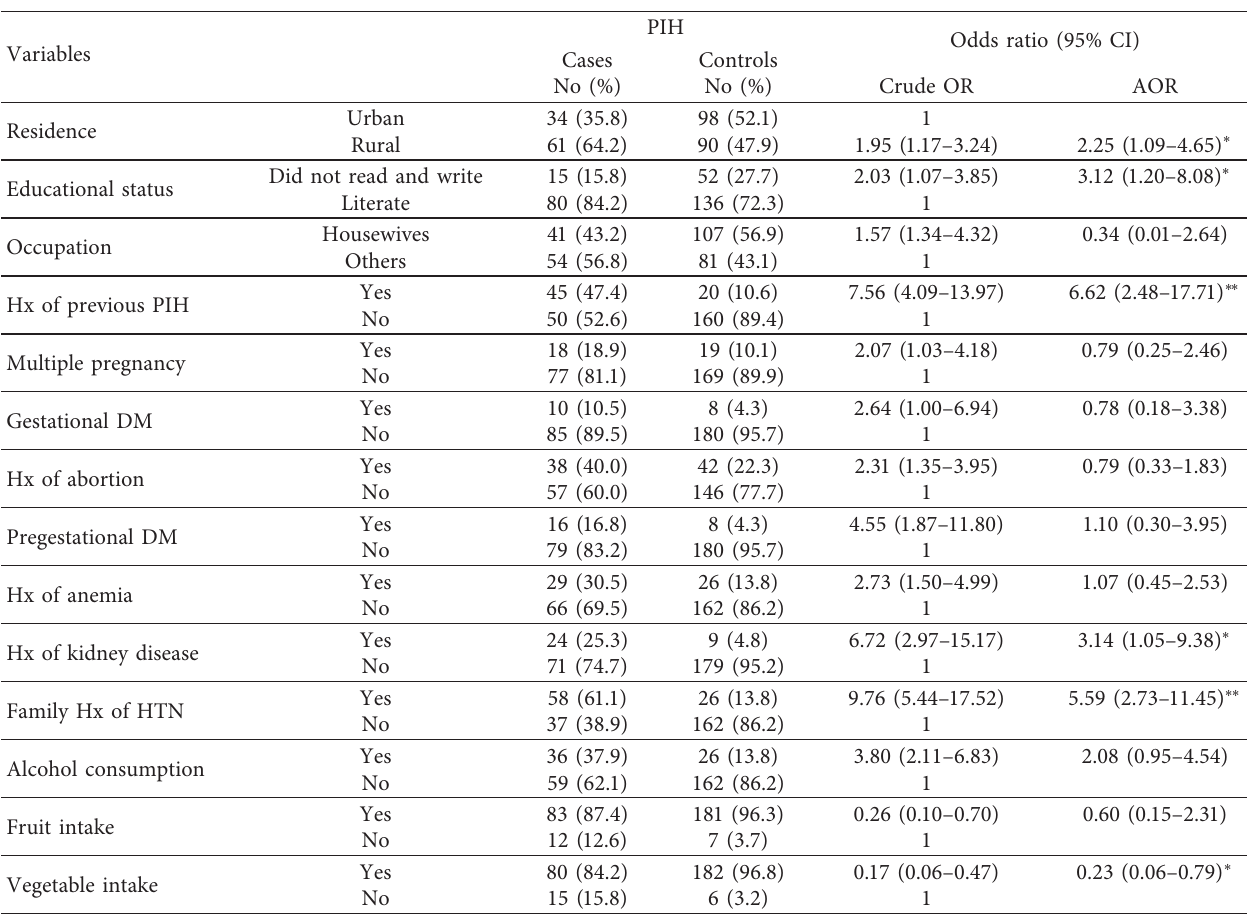
Table 6: Multivariable unconditional logistic regression analysis of predictors of hypertensive disorders of pregnancy in Wolaita